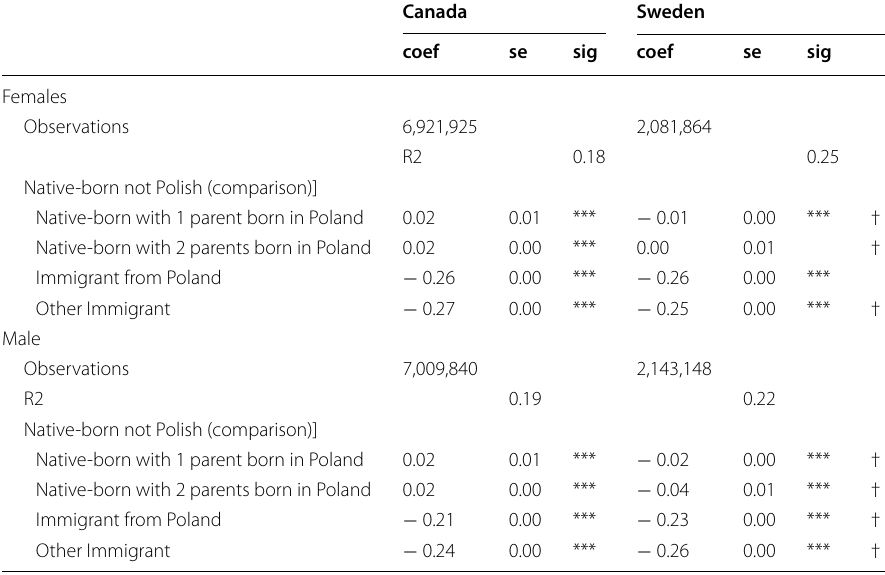
The 2016 Census of Canada is a 25% sample of Canadian households. As per Statistics Canada requirement we show the weighted number of observations Significance: *0.1; **0.05; ***0.01 Regressions control for age, age squared, years in the host country for immigrants, years in the host country squared, schooling, marital status, number of children and residence in the 3 largest cities † Indicates that the coefficients for Canada and Sweden are statistically different from each